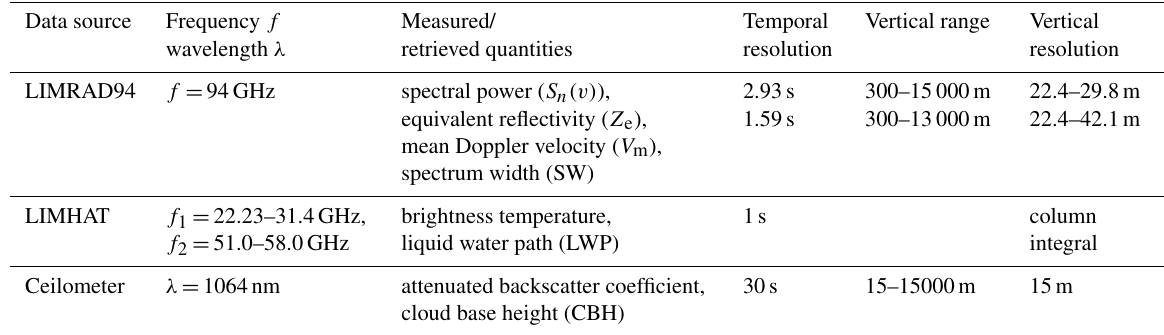
Table 1. Specifications of instruments and measured/retrieved quantities. For LIMRAD94, in the last three columns the upper values refer to the first chirp table used; the lower values refer to the second chirp table (see Table 2). The values in the last three rows refer to all the measured/retrieved quantities of the respective data source.